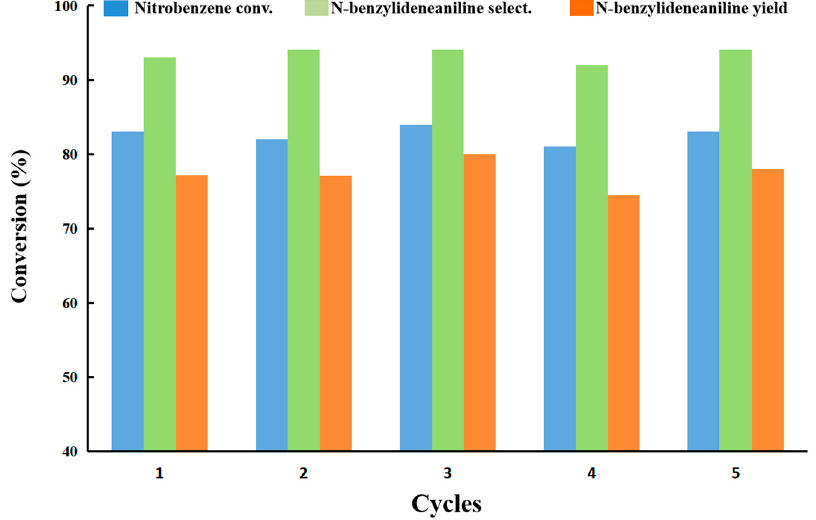
Figure 7. Photocatalytic stability of Co 0.6 Ni 0.4 S 2 /rGO in five cycles for synthesis of N -benzylideneani- line.